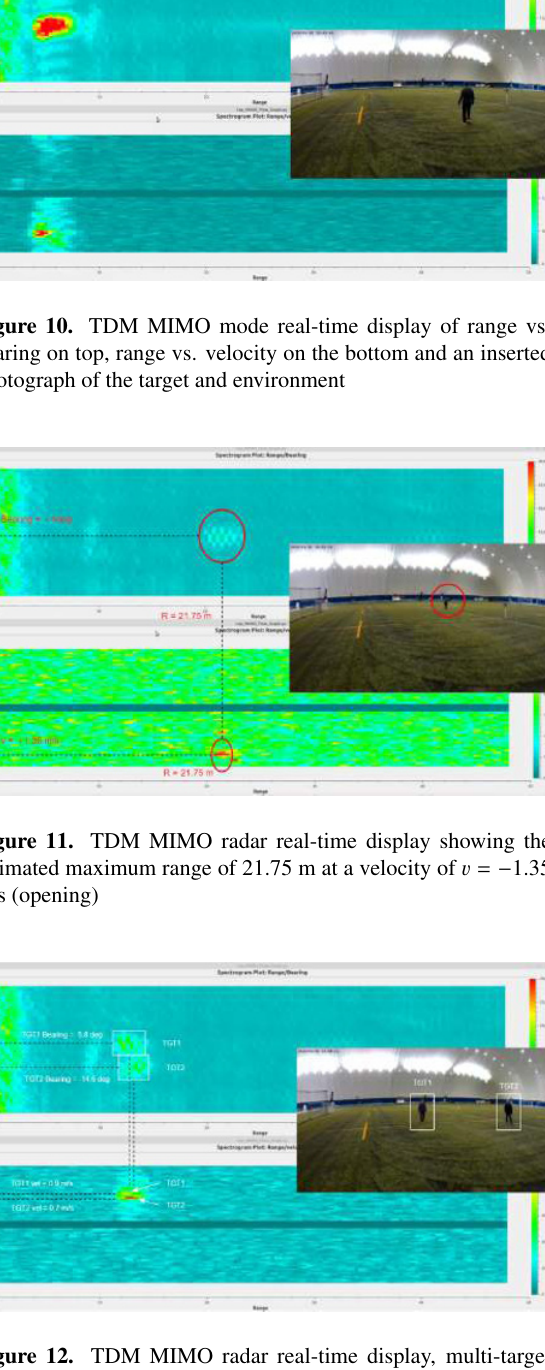
Figure 12. TDM MIMO radar real-time display, multi-target test, where TGT stands for target. TGT1 at a bearing of θ TGT 1 = 5 . 8, velocity of v TGT 1 = 0 . 9 m / s and a range of R TGT 1 = 12 . 4 m. TGT2 at a bearing of θ TGT 2 = − 14 . 5, v TGT 2 = 0 . 7 m / s and a range R TGT 1 = 12 . 6